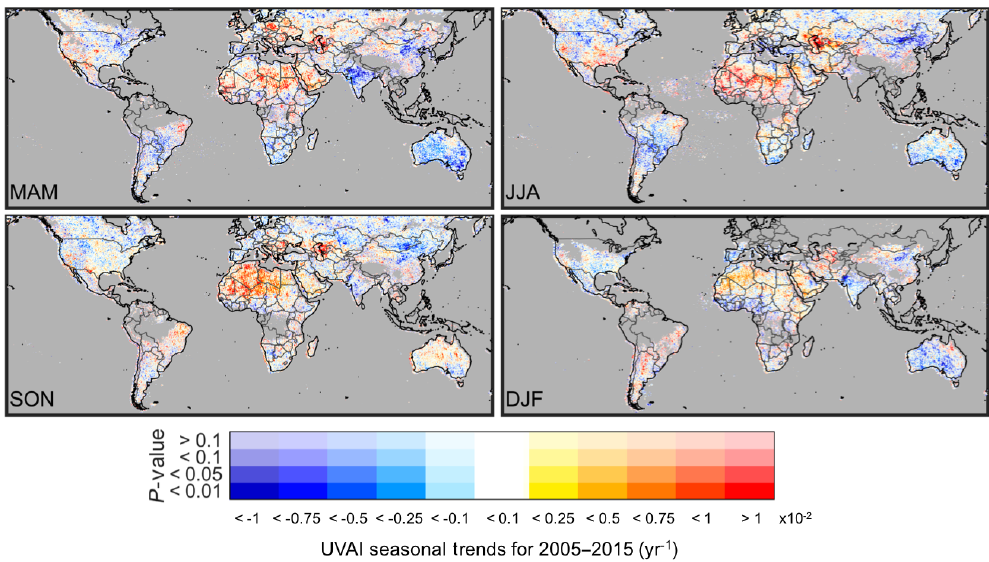
Figure 5. Seasonality of the trends in OMI UVAI values calculated from the generalized least squares regression of monthly time series values during 2005–2015 for MAM (May, April, March), JJA (June, July August), SON (September, October, November), and DJF (December, January, February). The opacity of the colours indicates the statistical significance of the trend. Grey indicates persistent cloud fraction greater than 5%.